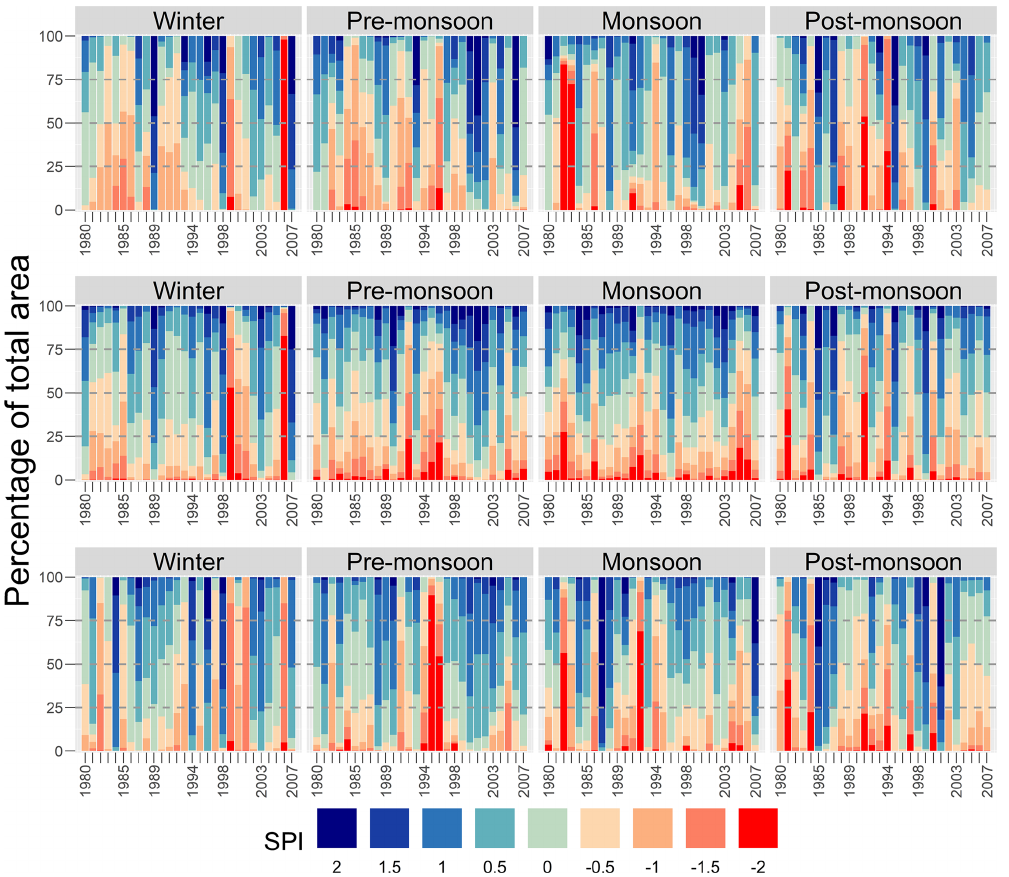
Figure 10. Spatial and seasonal variability in the SPI in the trans-Himalaya (top row), the mountains (middle row), and the plains (bottom row). Note: each colour band shows the respective HRU areas combined.